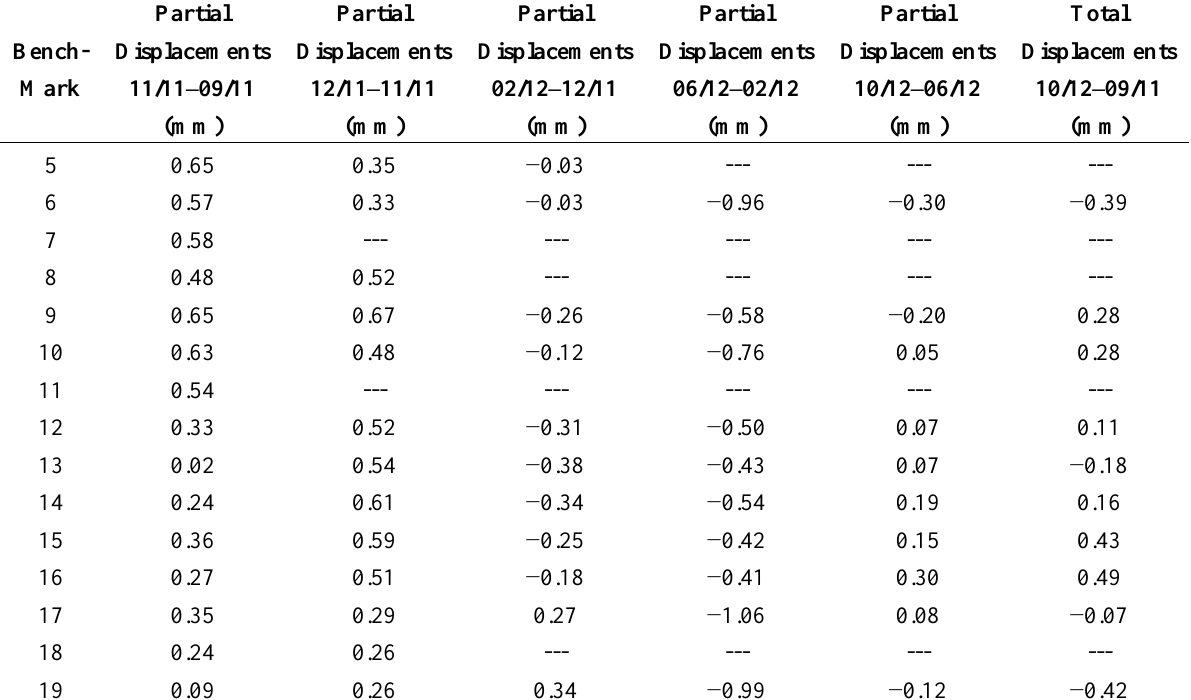
Table 1. Partial and total vertical displacements of the leveling bench marks on the columns and pillars of Palazzo del Capitano and adjacent Magna Domus . Missing data are due to benchmark